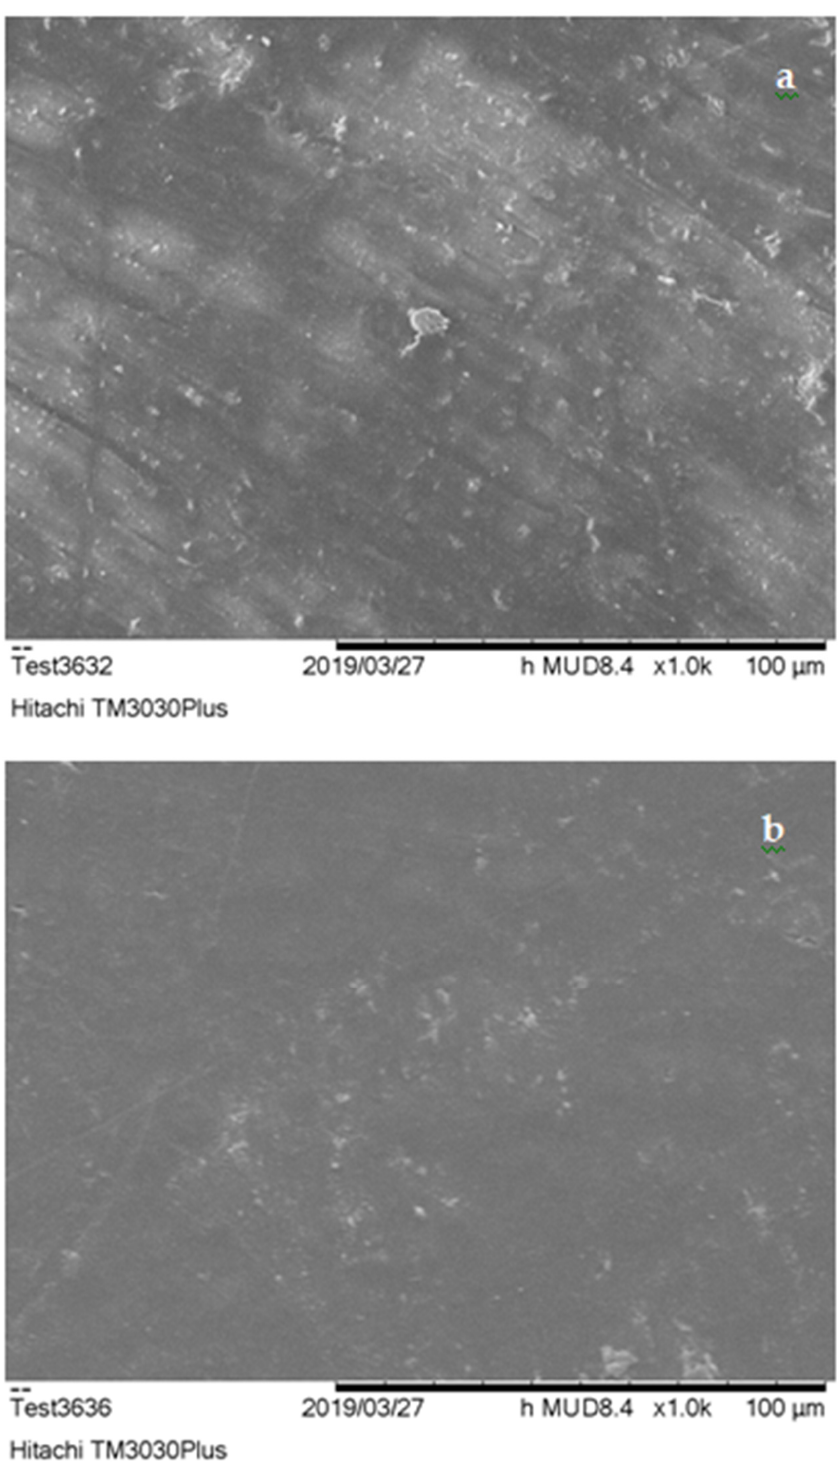
µ m construction and demolition (C&D) waste ( w / w Figure 4. ERCs SEM imaging; ( a ) 30% of 500 μ m construction and demolition (C&D) waste ( w/w ), Figure 4. ERCs SEM imaging; ( a ) 30% of 500